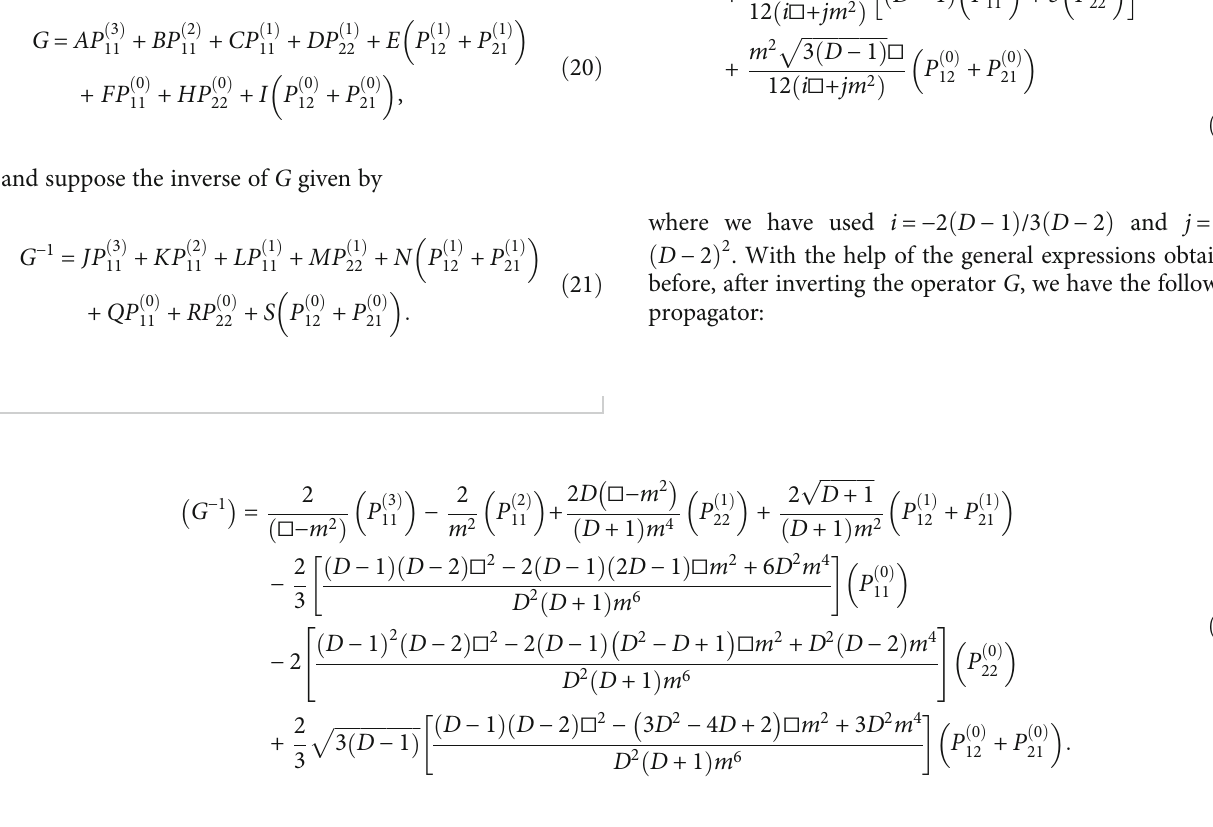
ffiffiffiffiffiffiffiffiffiffiffiffiffiffiffiffiffi 3 D − 1